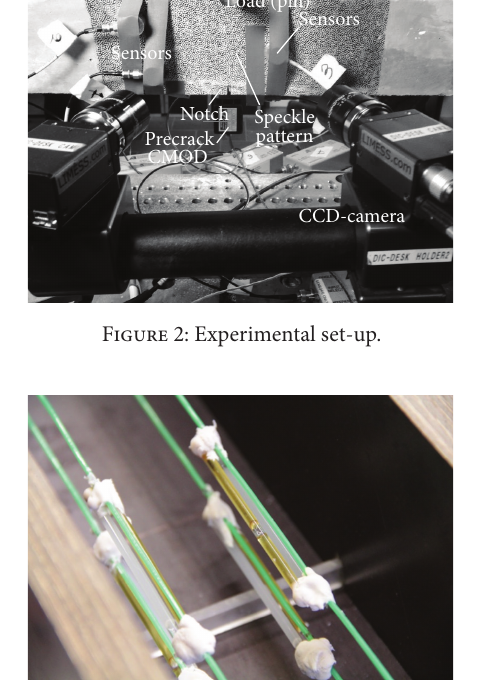
Figure 3: Series of capsules placed into the mold during